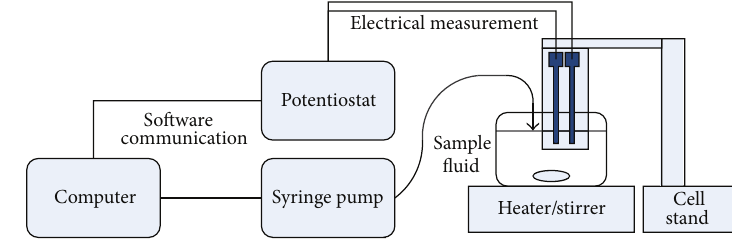
Figure 10: Schematic of the electrochemical cell test setup.